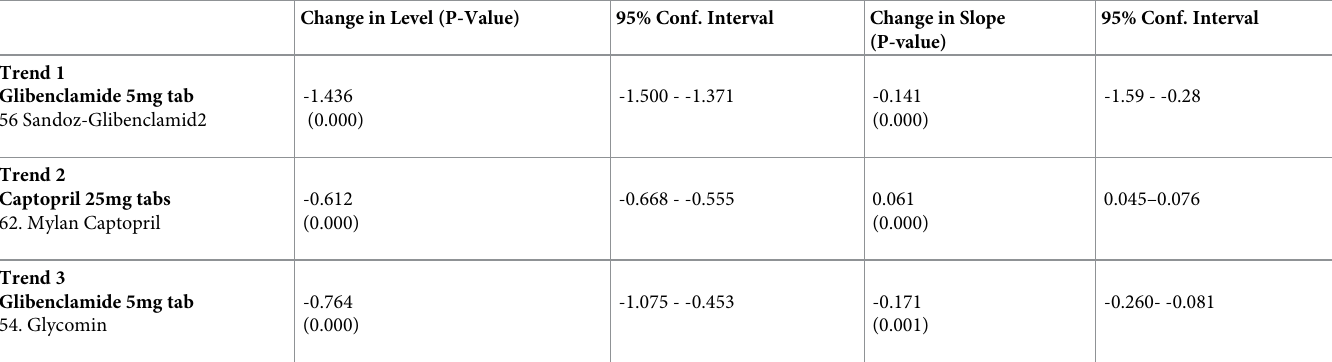
Table 4. Three emerging trends with changes in slope and level.